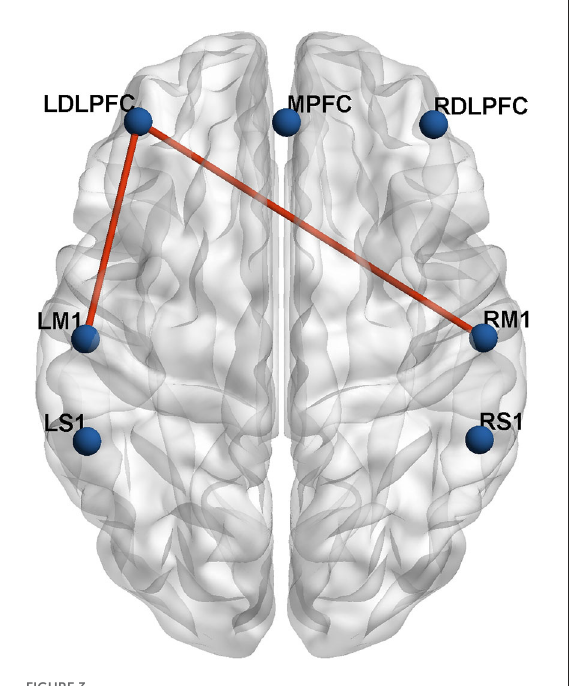
FIGURE3 The inter-group differences in actual ROIs represented by automated anatomical labeling (AAL) atlas in axial view. The blue nodes represent the seven regions of interest. The red lines represent the connections with significant differences ( p < 0.05) between the mild group and severe